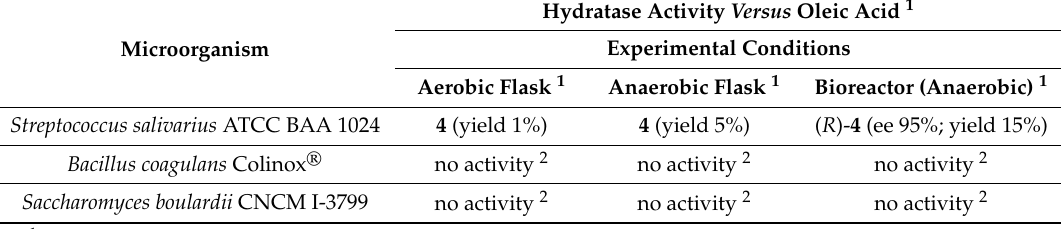
Table 2. Results of the microbial biotransformation of oleic acid by three anaerobic facultative probiotic